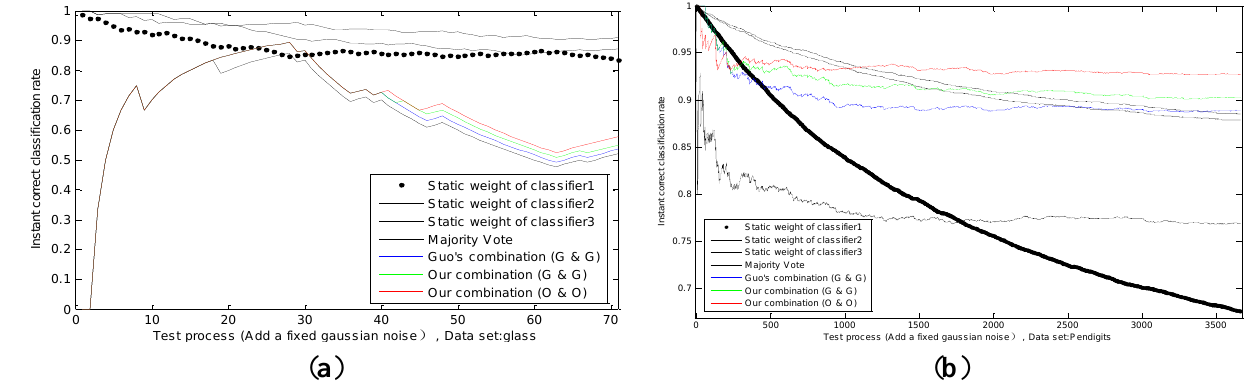
Figure 6. Instant result of different methods in the whole test process on dataset glass ( a ) and pendigits ( b